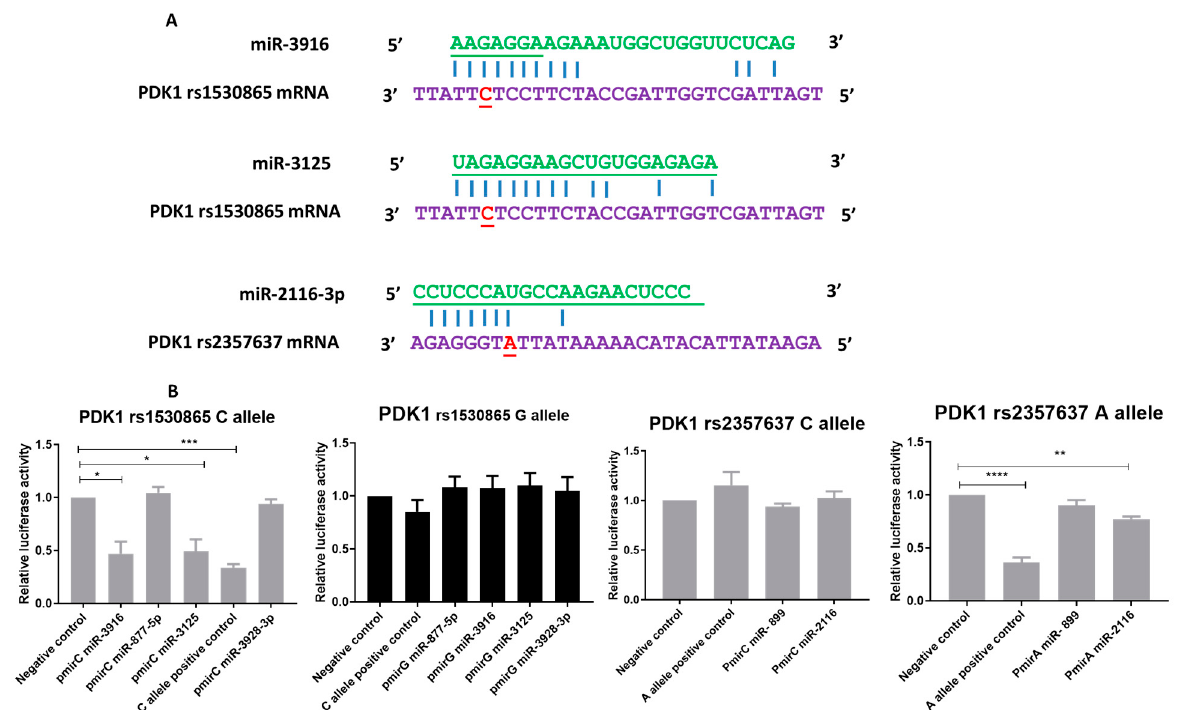
Figure 5. miR-3916-3p and miR-3125 target the PDK1 rs1530865 miRSNP C allele, and miR-2116 targets the PDK1 rs2357637 miRSNP A allele. ( A ) miRNAs miR-3916 and miR-3125 were predicted to interact with the PDK1 rs1530865 miRSNP C allele. Similarly, and miR-2116 predicted to target the rs2357637 miRSNP A allele. Base pairing is shown by a solid vertical line. ( B ) Luciferase reporter assays to measure C/G and C/A allele differential interaction at the PDK1 rs1530865 SNP and PDK1 SNP rs2357637, respectively. LNCaP cells were transfected with C/G and C/A containing reporter constructs and the miRNA mimics. Renilla luciferase activity was normalised to firefly luciferase, and results are presented as a percentage relative to luciferase activity. Data are shown from 3 independent experiments. Reduced luciferase activity observed with the co-transfection of miR-3916, miR-3928 for the rs1530865 miRSNP C allele and miR-2116 with rs2357637 miRSNP A allele. Statistically significant differences were assessed using a one-way ANOVA with Tukey’s multiple comparison test; Mean ± SEM, n = 3, p < 0.0001 ****, p < 0.001 ***, p < 0.01 **, p < 0.05 *.